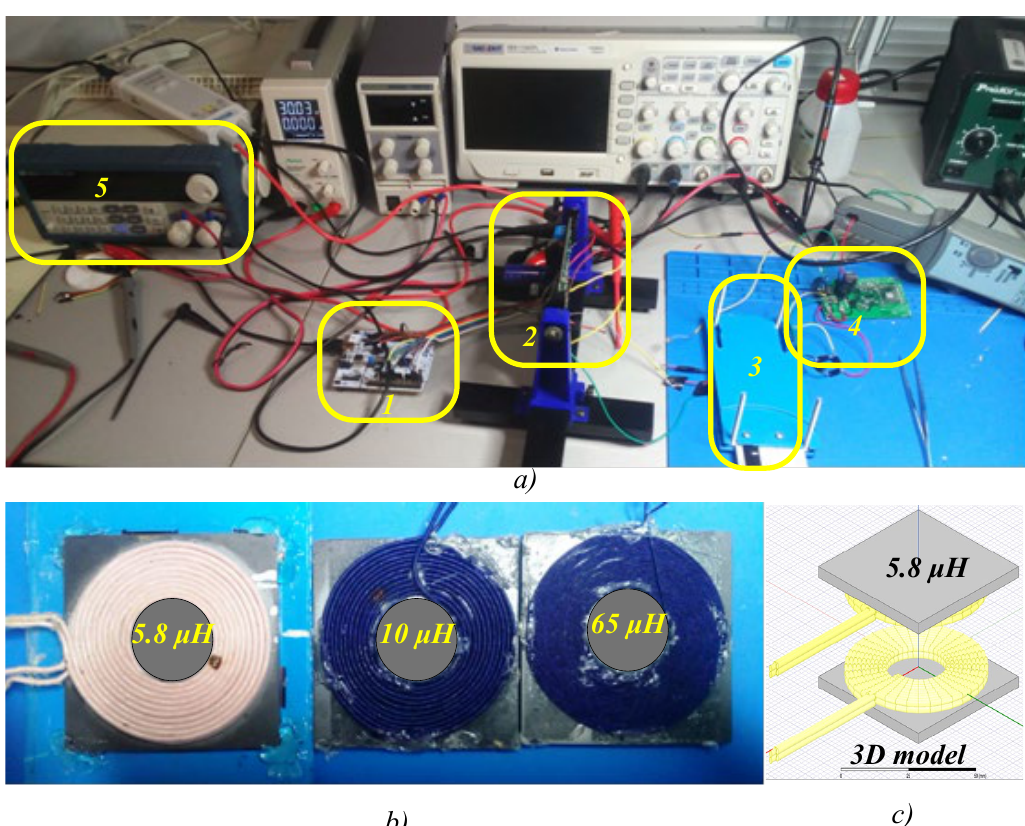
Fig. 2. Investigating WPT system and designed coils: a) experimental laboratory WPT system; b) tested coils; c) double-layer coil 3D